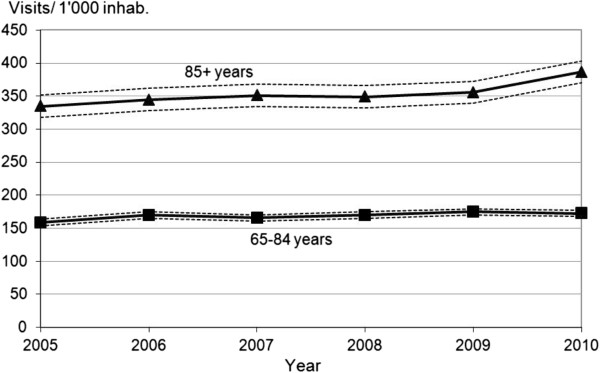
Evolution from 2005 to 2010 of the incidence ratea of Emergency Department visits by the permanent resident population of Lausanneb by age groups. Legend: a And its upper and lower 95% confidence intervals. b Includes districts of Lausanne and West Lausanne, Statistique Vaud 2012.